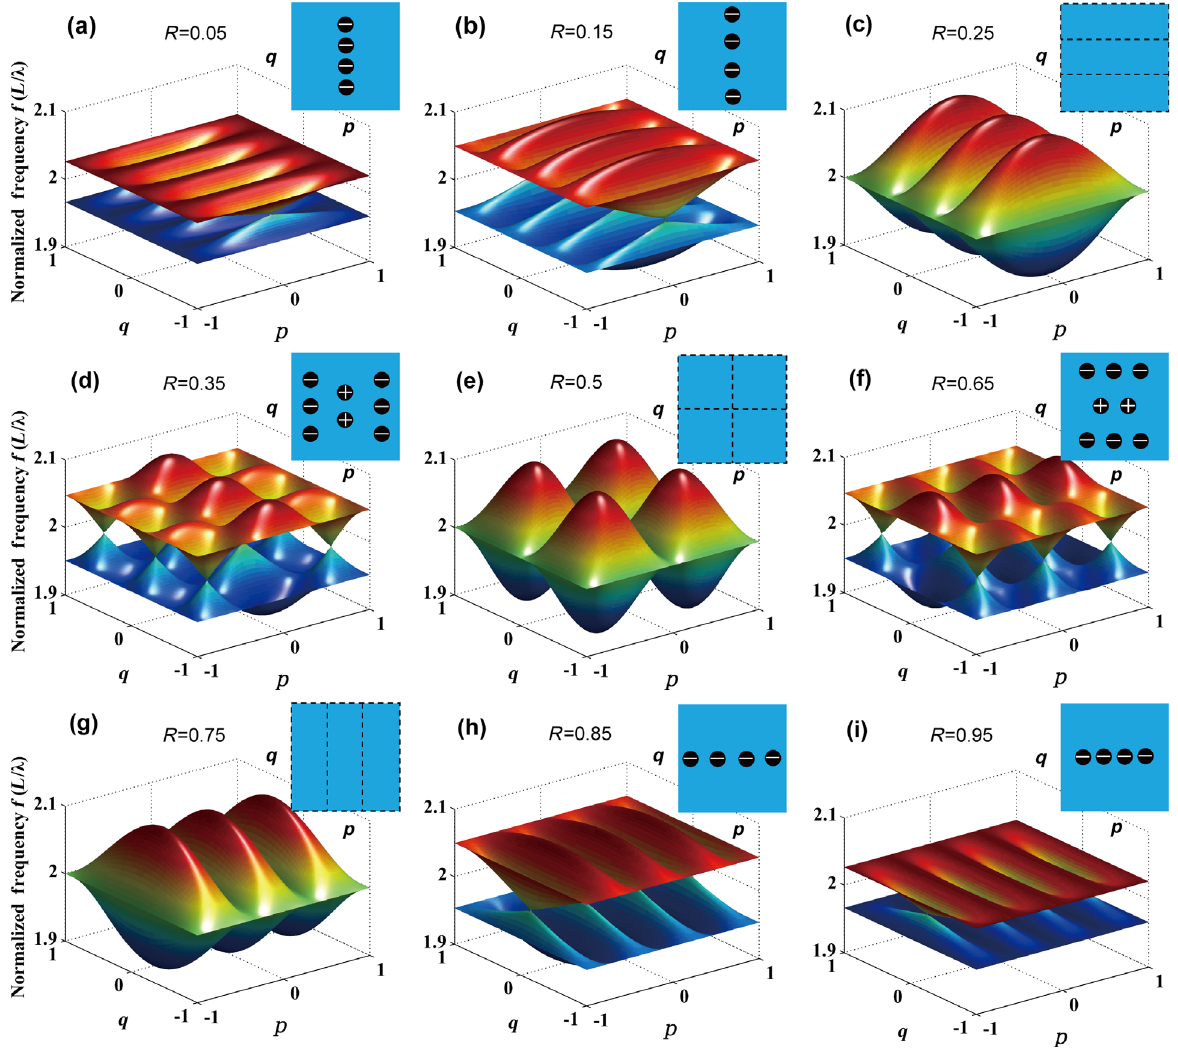
FIG. 5. Topological transitions occur as we change the parameter R defined in the text. (a) – (i) Band structures of band 4 and band 5 with different values of R at k ¼ 0 . The values of R are 0 . 05 , 0.15, 0.25, 0.35, 0.5, 0.65, 0.75, 0.85, and 0.95 for (a) – (i), respectively. The insets show the positions of the Weyl points ( “ þ ” for positive charge and “ − ” for negative charge) and “ nodal lines ” (black dashed